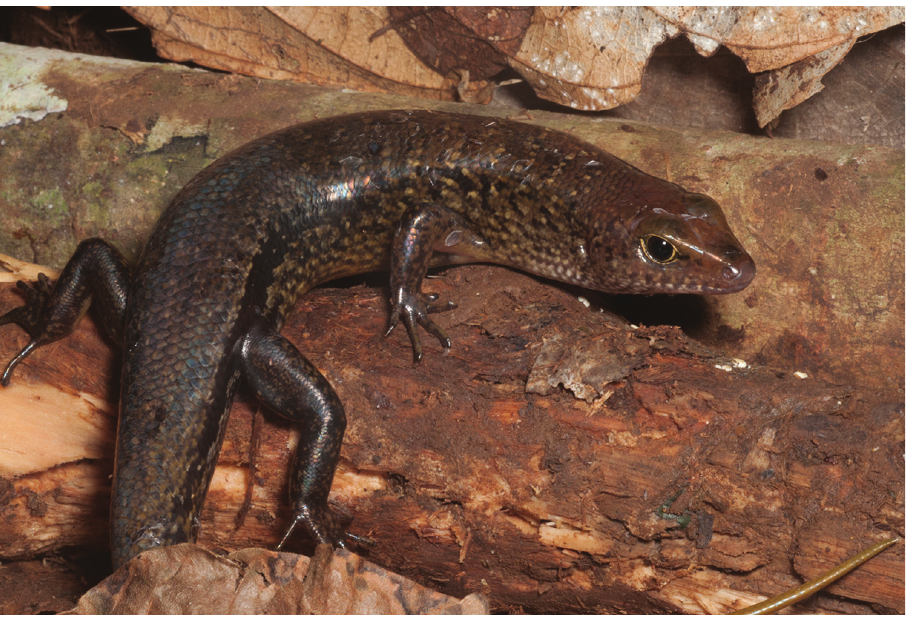
Figure 58. Pinoyscincus abdictus abdictus (KU 334268) from Mt. Hilong-hilong, Municipality of Remedios T. Romualdez, Agusan del Norte Province. Photo: